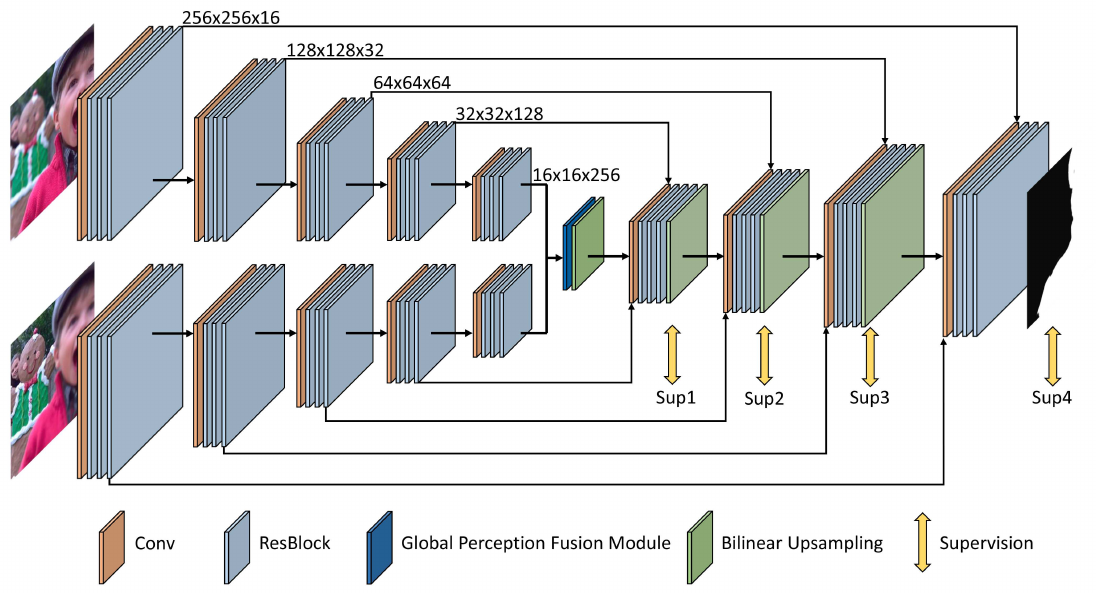
Figure 3. The architecture of our proposed U-shape multi-focus image fusion network with a Siamese encoder. The Siamese encoder extracts the features of two input images simultaneously, and fuses them through the global perception fusion module in the bridge stage of the network. Each stage of the decoder cascades the feature maps from the corresponding stage of the Siamese encoder and outputs a decision map, which participates in the supervision of the training. ResBlocks are added in each stage of the encoder and